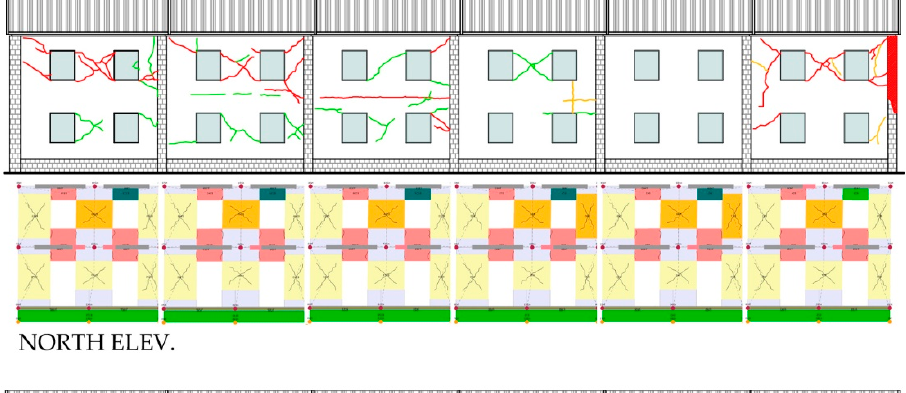
Figure 9. FME model, southeast 3D view: ( a ) single-unit model (unit no. 6); ( b ) whole terrace. Key to colour: piers in orange, spandrels in green, rigid nodes in blue. Black dot indicates control nodes for single-cell and whole terrace analyses, respectively (see Section 3.1.1).